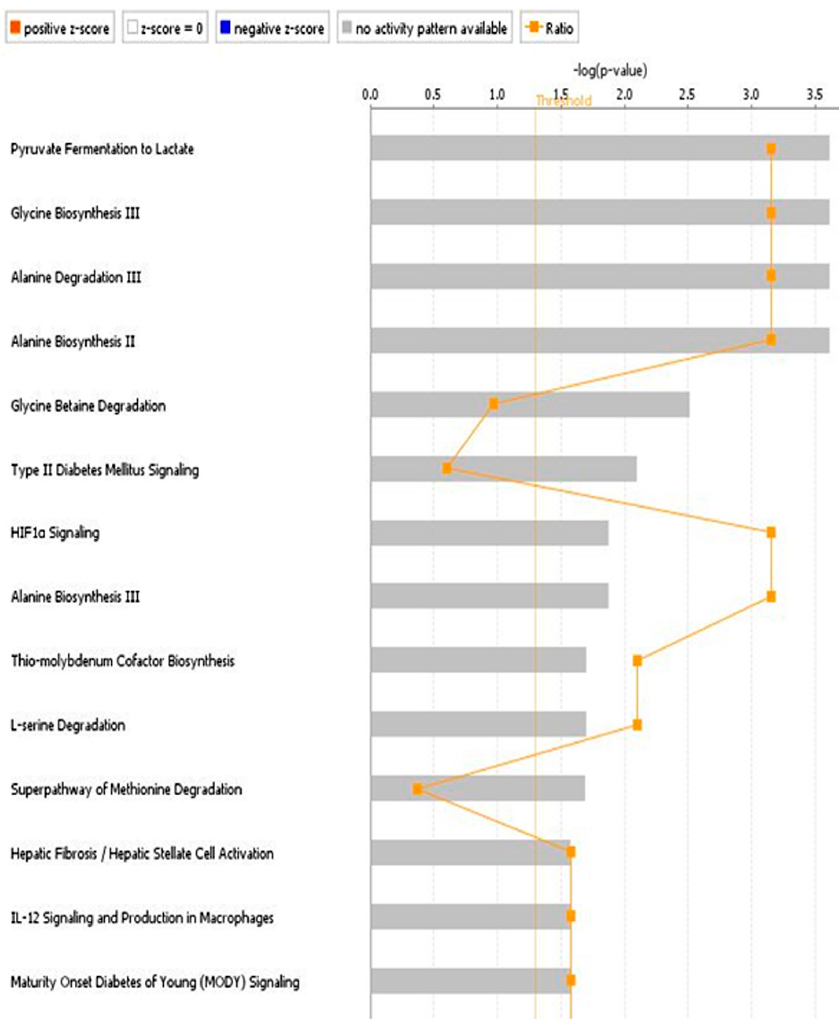
Figure 3. Pathways most differentially modulated in ccRCC patients generated from urinary metabolites obtained through variable size bucketing.